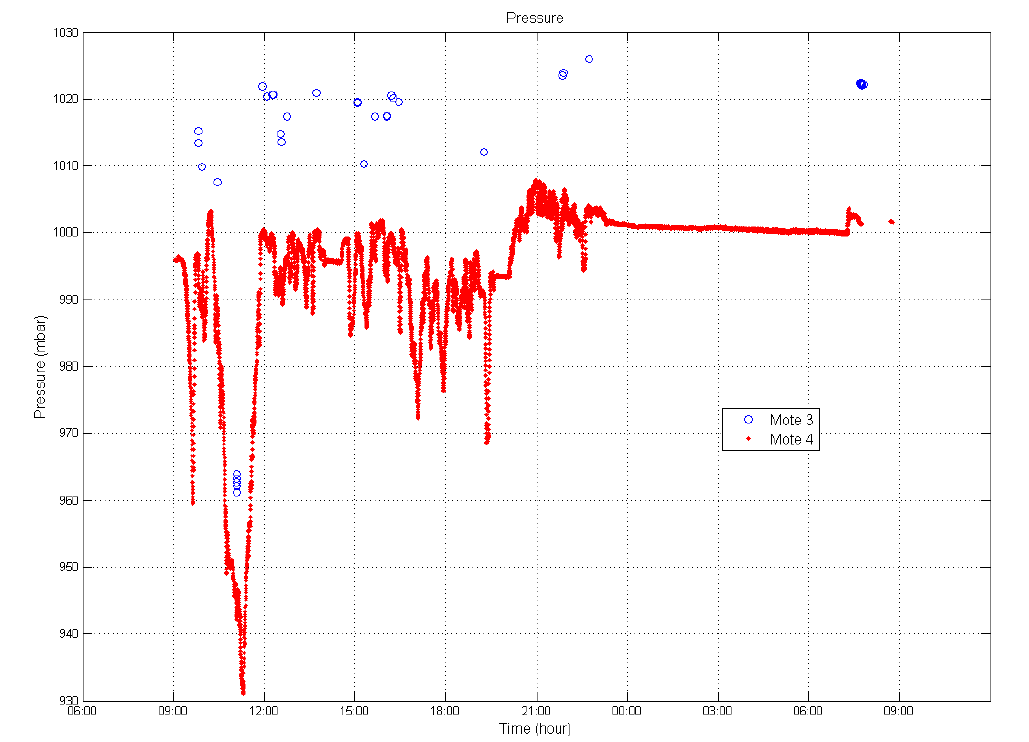
Figure 5. Light detection during the